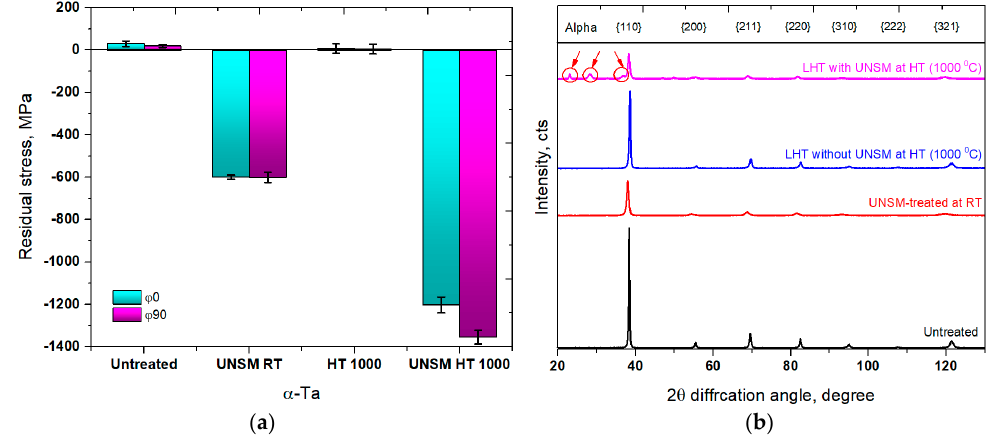
Figure 3. Variation in surface residual stress ( a ) and X-ray diffraction (XRD) pattern ( b ) of the untreated, UNSM-treated at RT and LHT without and with UNSM treatment at 1000 °C specimens. XRD patterns of the specimens are presented in Figure 3b. The relative intensities of all the diffraction peaks of the untreated specimen were reduced significantly after UNSM treatment at RT. By treating the specimen by LHT without UNSM treatment at HT led to a negligible reduction in intensity in comparison with the untreated specimen, but a substantial reduction in intensity was found for the specimen by LHT with UNSM treatment at HT, which is lower in comparison with the UNSM-treated specimen at RT. Post-polishing process of the specimens treated by LHT with and without UNSM treatment at HT was responsible for the absence of any diffraction peaks of the oxide particles on the surface. The high-temperature UNSM treatment, regardless the treatment temperature, may result in the formation of thick oxide layer, which is responsible for the deteriorated mechanical properties [26]. In addition, new diffraction β diffraction peaks {101}, {400} and {410} are detected after LHT with UNSM treatment at HT (see the inset in Figure 3b), which means that the phase transformation occurred from α → β . Beta Ta is a metastable phase that is transformed from α Ta when it heated up to 900 °C [37]. The α phase is tend to have excellent corrosion, thermal ductility properties, while the β Ta provides additional hardenability, therefore the newly appeared β phases are expected to beneficially affect the strength, wear performance, and fatigue strength.